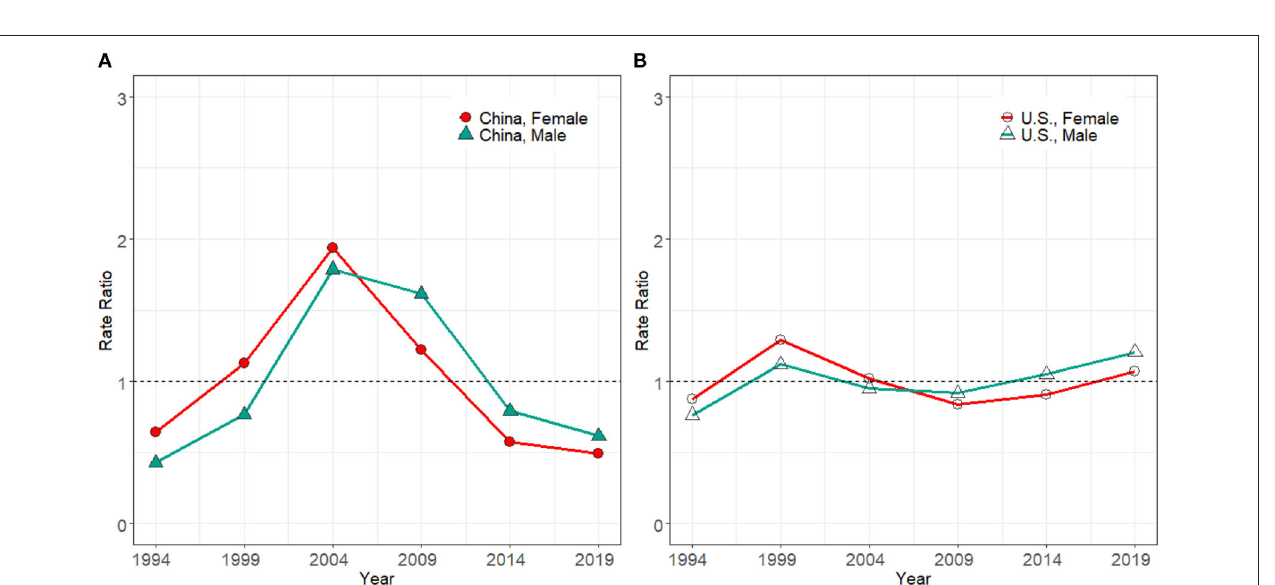
( Figure 4A ). It had no sign of decline until it reached the highest in 2004. The RR for both men and women in China in 2014 was, respectively, 1.87 and 1.9 times larger than that of the U.S. during the same period. After which, the upward momentum was curbed and glided down to the level of